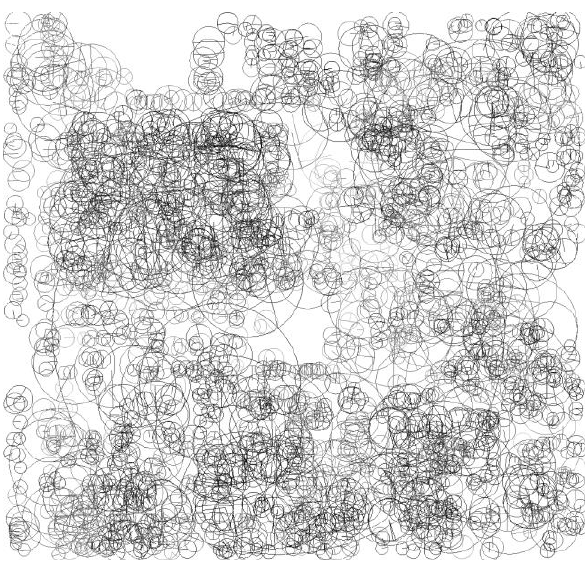
Figure 1. A set of SIFT primitive-Gestalten as obtained from Image #9, grey tones code